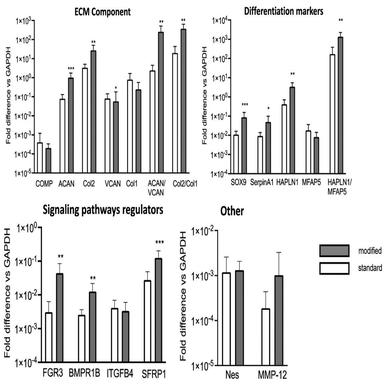
Quantitative reverse-transcription polymerase chain reaction analyses of N-TEC generated with the modified (gray bars) and standard protocol (white bars); gene expression is relative to glyceraldehyde 3-phosphate dehydrogenase levels. Values are mean § standard deviation of samples from five different donors. P < 0.05, P < 0.005, P < 0.0005, P < 0.00005.